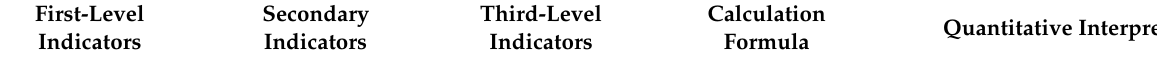
Table 1. Pedestrian accessibility and safety index system of children’s school travel road.